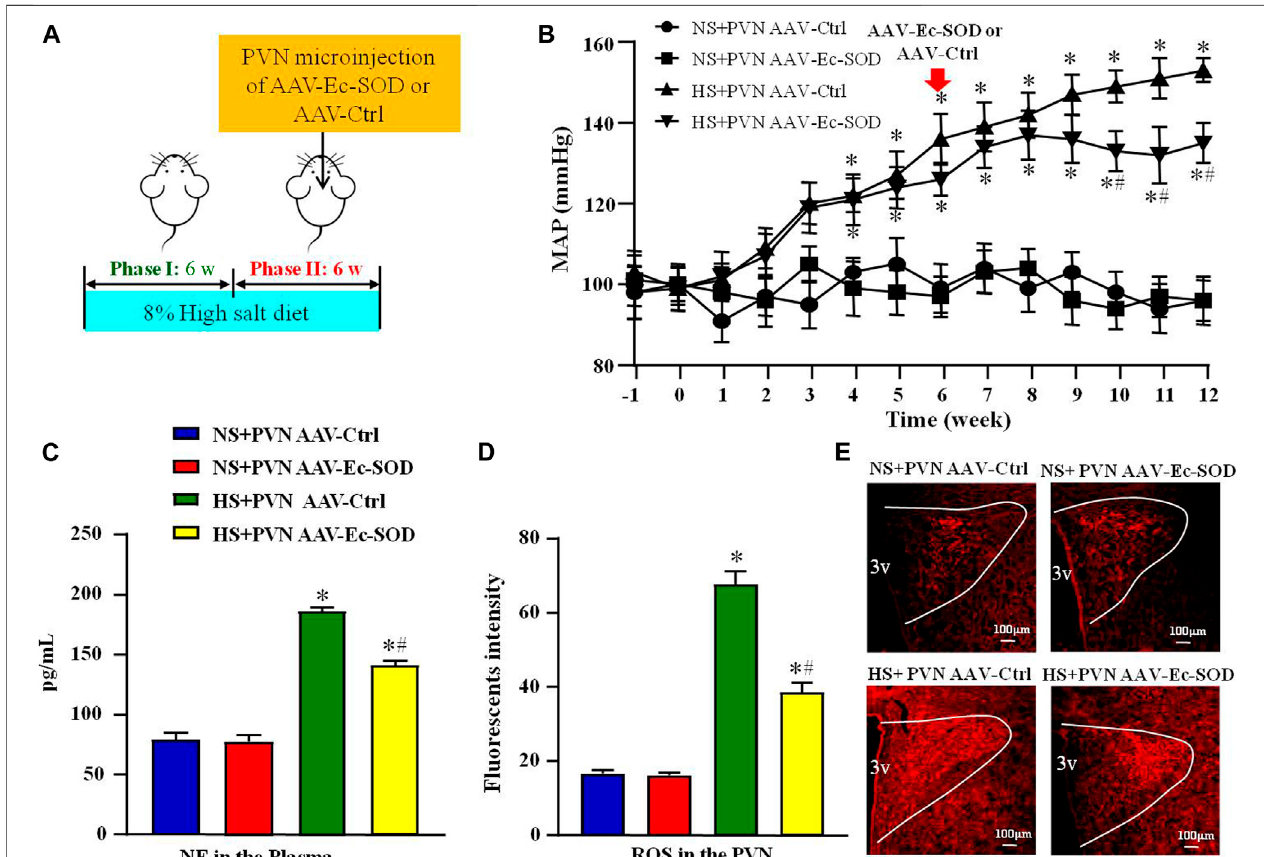
FIGURE 1 | Effect of AAV-Ec-SOD on mean arterial blood pressure, plasma noradrenaline and PVN level of superoxide anion (A) Schematic diagram for the experimental protocol; (B) Line chart comparing the effect of AAV-Ec-SOD on mean arterial blood pressure (MAP) during the 12 weeks; (C) Column diagram analysis of the plasma noradrenaline (NE) in different groups; (D – E) Immuno fl uorescence fordihydroethidium (DHE) and Column diagram showing theimmuno fl uorescent intensity of DHE in the PVN in different groups. 3V represents the third ventricle in brain. Values are expressed as mean ± SEM (n (cid:2) 6). * p < 0.05 vs. NS groups (NS + PVN AAV-Ctrl or NS + AAV-Ec-SOD); # p < 0.05 vs . HS + PVN